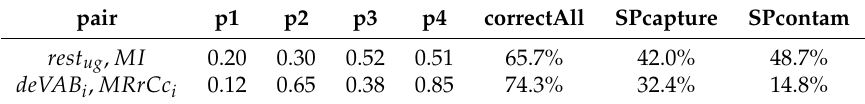
Table 2. Classification results for two-level, two-feature trees like that in Figure 2. Columns p i represent the average fraction P SP , across galaxies in leaf node i , of GZ1 humans who voted that object to be a spiral galaxy, across the training set. This value is then the assigned P SP for any non-training-set galaxy placed in this leaf node. correctAll : assuming P SP > 0.5 represent a positive spiral classification, the percentage across all galaxies of correct classifications; SPcapture : the fraction of true spirals that are captured by this classification scheme. SPcontam : the fraction of galaxies classified as spiral that are incorrectly classified. Top row : exactly the tree of Figure 2. Second Row : a pair that arguably performs better because it has a higher total correct classification, primarily because it has far less contamination of non-spirals, even though it has a smaller capture fraction. It demonstrates that we can have 75% correct classifications even with just a two-parameter, two-level tree. See Table 1 for the meaning of the input variables.